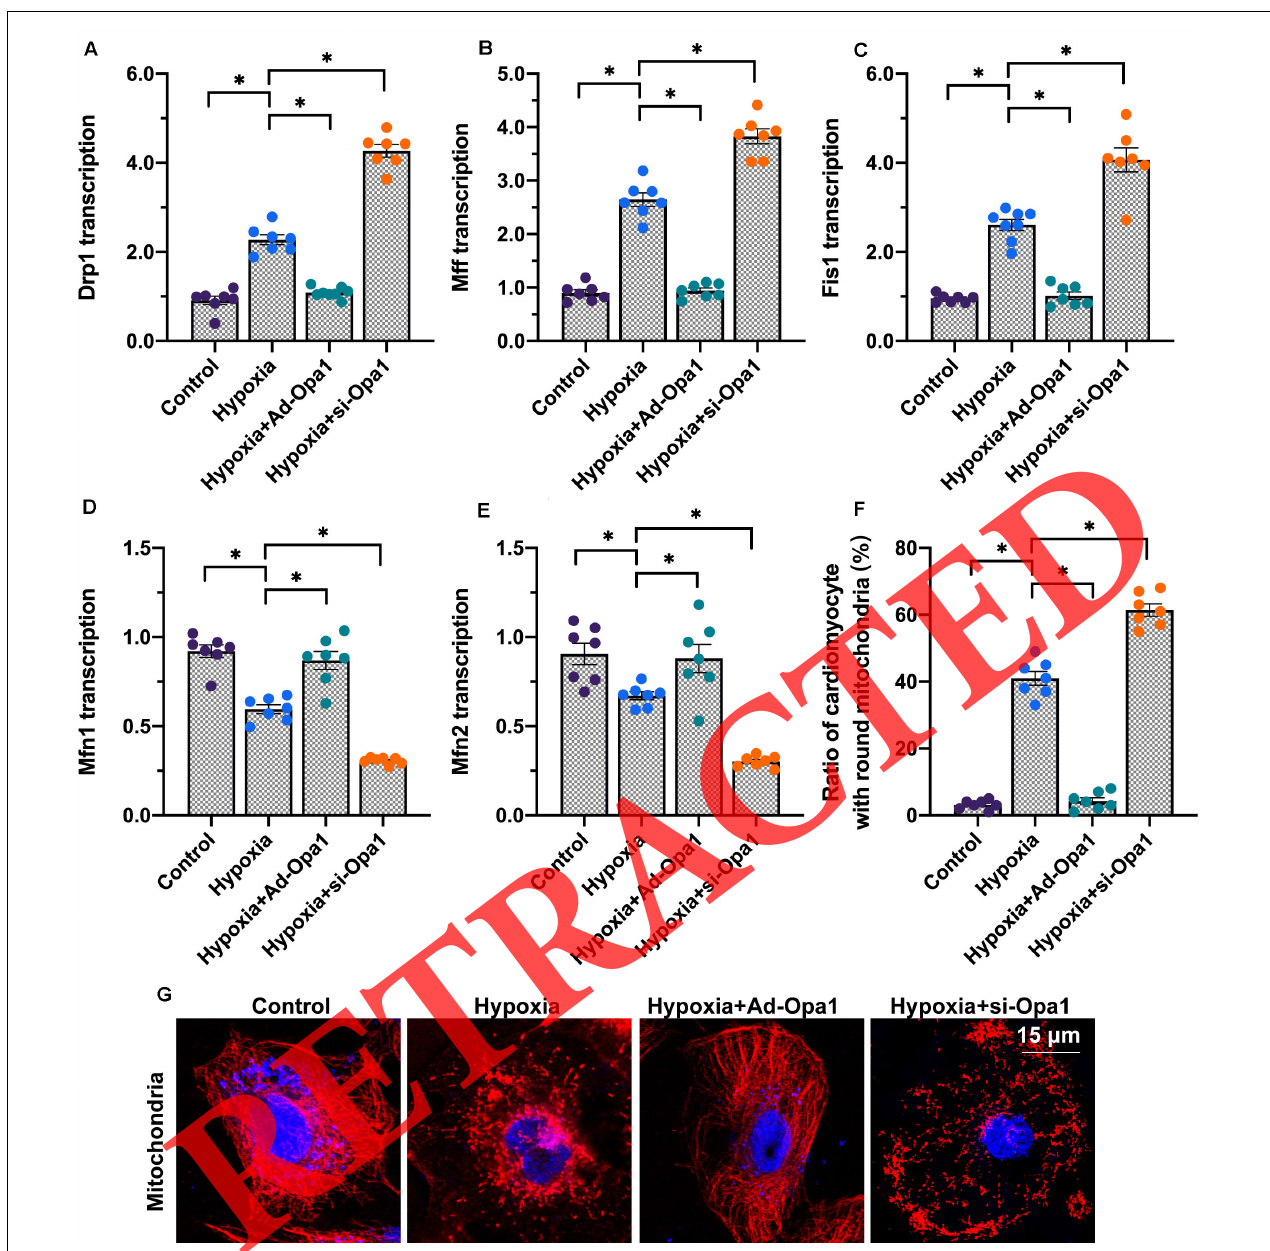
FIGURE 4 | Opa1 inhibits mitochondrial fission and enhances mitochondrial fusion. (A–E) Analysis of Drp1, Mff, Fis1, Mfn2, and Mfn1 expression through qPCR. (F,G) Analysis of mitochondrial morphology using immunofluorescence. The ratio of spindle-shaped to round mitochondria was estimated. ∗ p <